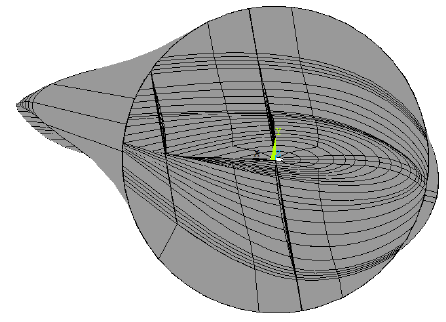
Figure 15. Rotation angle of the webs.